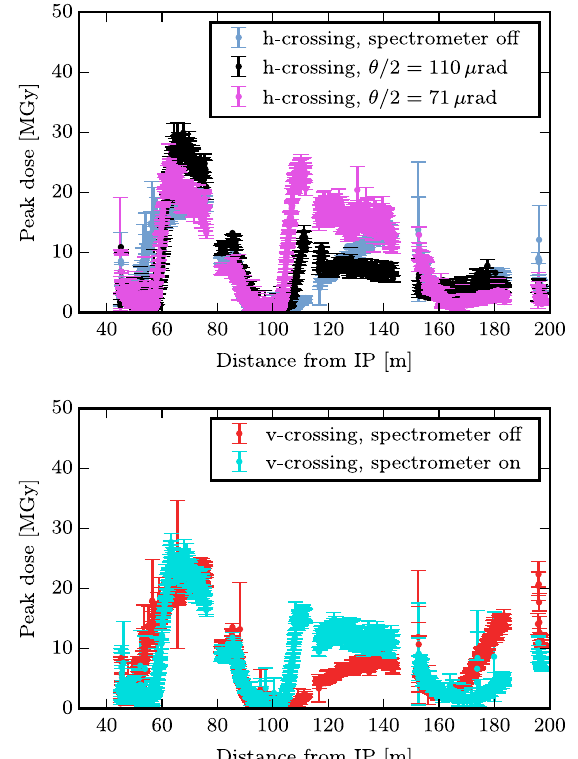
FIG. 13. Peak dose distributions per 3000 fb − 1 for the L (cid:2) ¼ 45 m scenario with and without spectrometer. The strong early deflection of the debris due to the spectrometer leads to a significant peak dose increase, most notably in